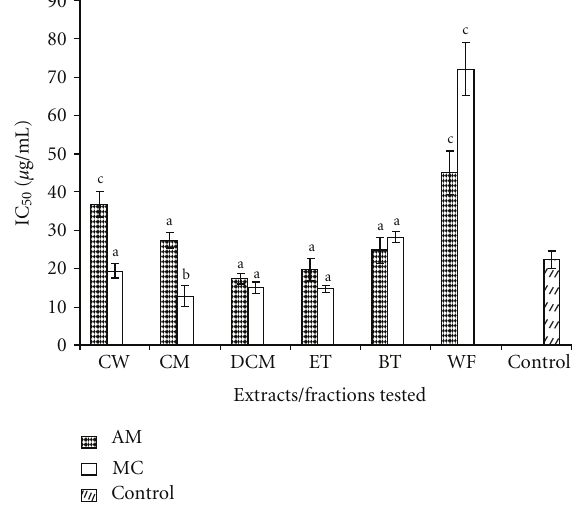
Figure 3: Summary of IC 50 values ( μ g/mL) for the active ex- tracts/fractions of AM and MC against α -glucosidase activity. CW: crude water; CM: crude methanol; DCM: dichloromethane; ET: ethylacetate; BT: n -butanol; WF: water fraction. Positive control: 1- Deoxynojirimycin. a Values comparable to positive control (1-Deo- xynojirimycin). b Values significantly lower ( P < 0 . 05) from positive control. c Values significantly higher ( P < 0 . 05) compared to positive